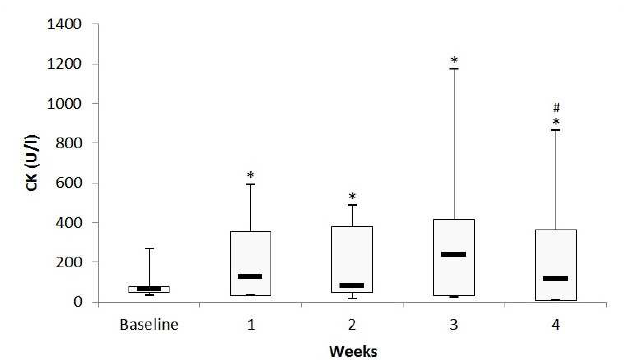
Figure 3. Creatine Kinase (CK) activity obtained at baseline and after the last training session of weeks 1-4. * p < 0.05 compared to baseline value. # p < 0.05 compared to third week value.